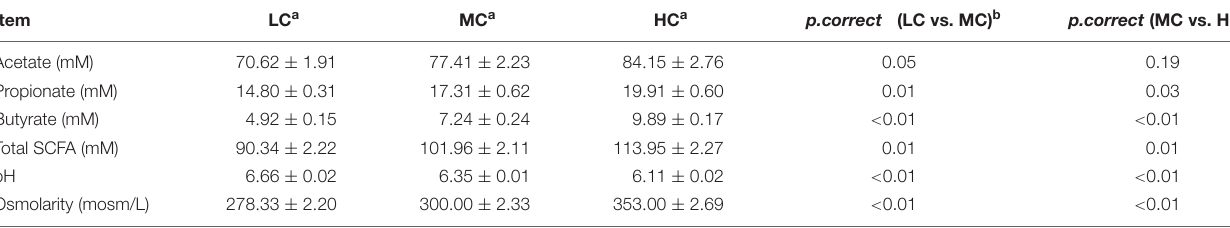
TABLE 3 | Effects of LC, MC and HC diets on the concentrations of SCFAs, pH, and osmolarity in the goat